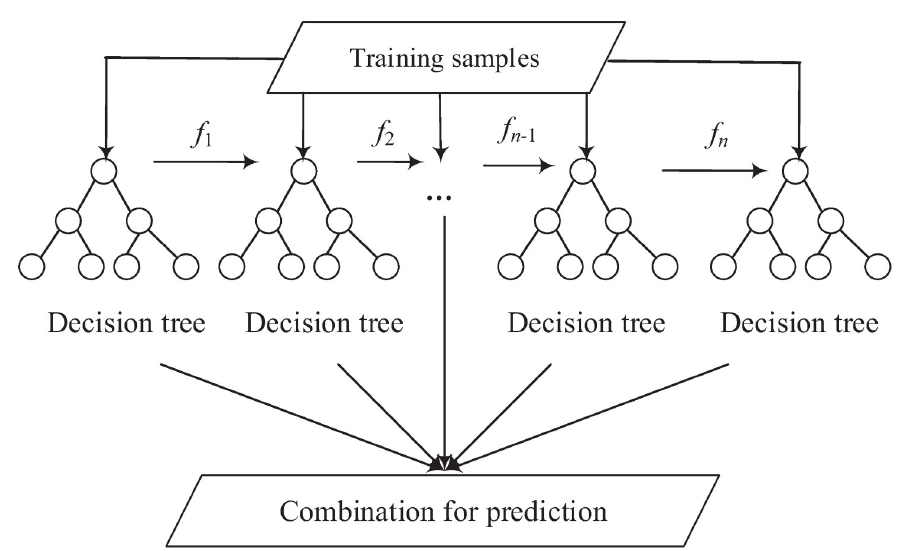
Fig 7. An example of the XGBoost